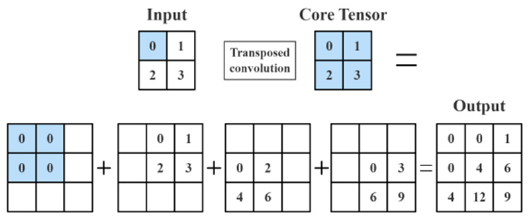
Figure 2. The example of the sampling method (when n and k are 2, s = 1, p =